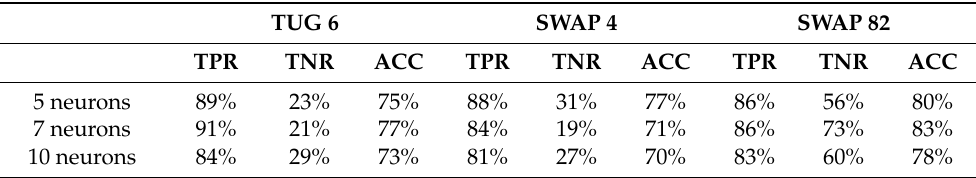
Table 5. Sensitivity (true-positive rate, TPR), specificity (true-negative rate, TNR), and accuracy (ACC) for the faller classification using the TUG 6, SWAP 4, and SWAP 82 tasks with different number of ANN neurons (averaged over number of epochs and regularisation approach).